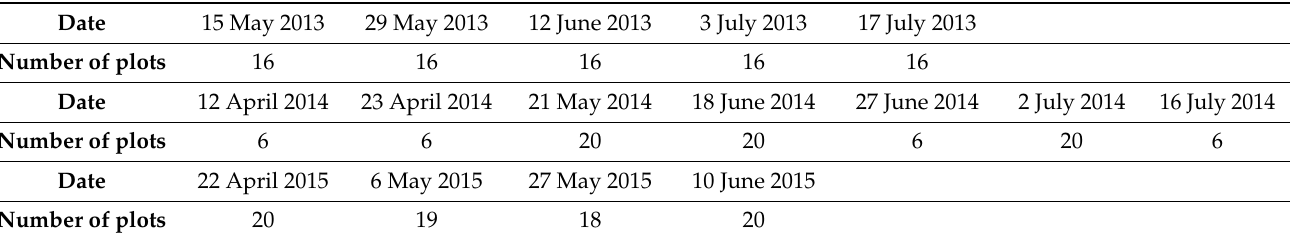
Table A1. Dates and number of plots for LAI measurements in the three years 2013, 2014, and 2015.